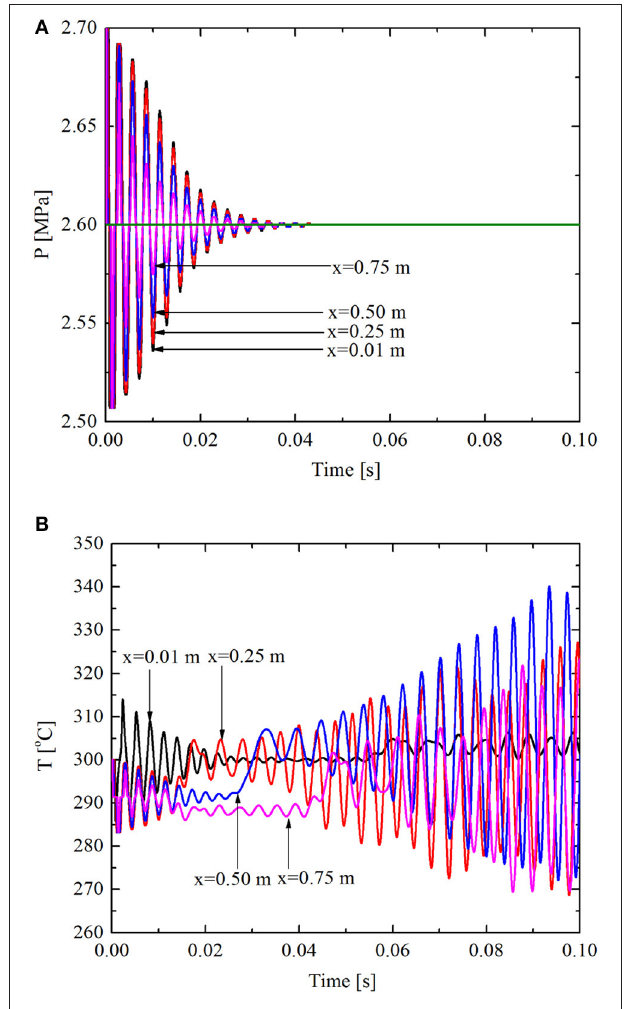
FIGURE 2 | Responses of the semi-implicit method under outlet pressure transient. (A) Pressure responses. (B) Temperature responses.